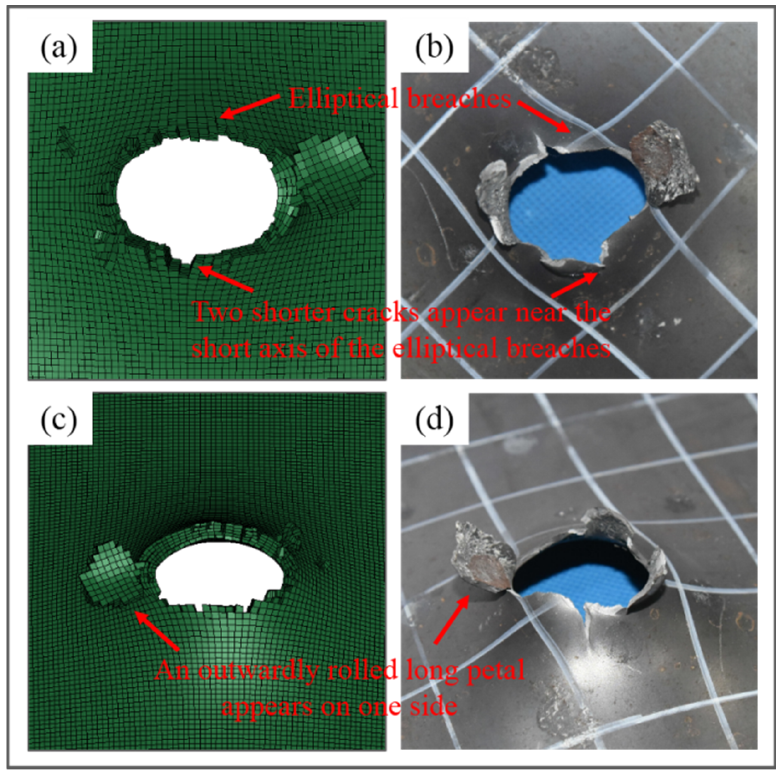
Figure 7. Comparison of back plate damage morphology in Experiment 3.